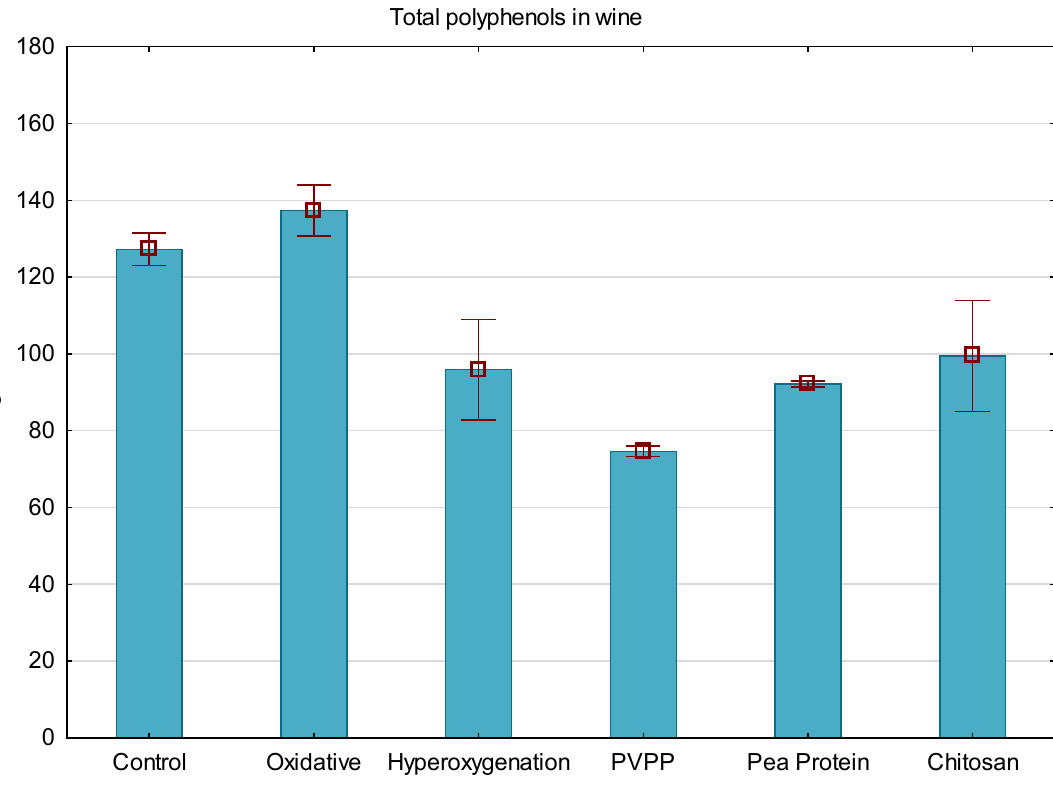
Figure 2. Concentration of total polyphenols in individual variants grape wines.